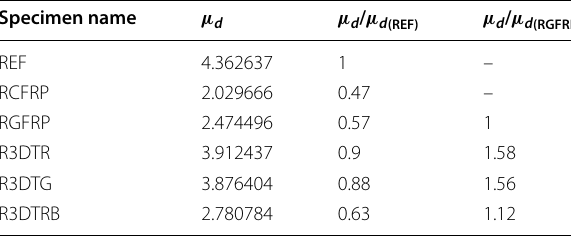
Table 9 Ductility indices of all specimens.